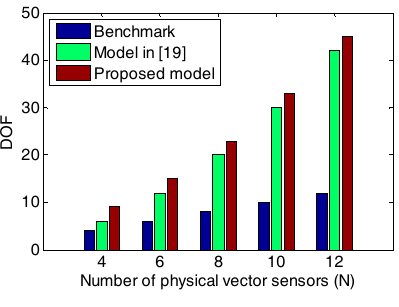
Figure 9. DOF vs. N .